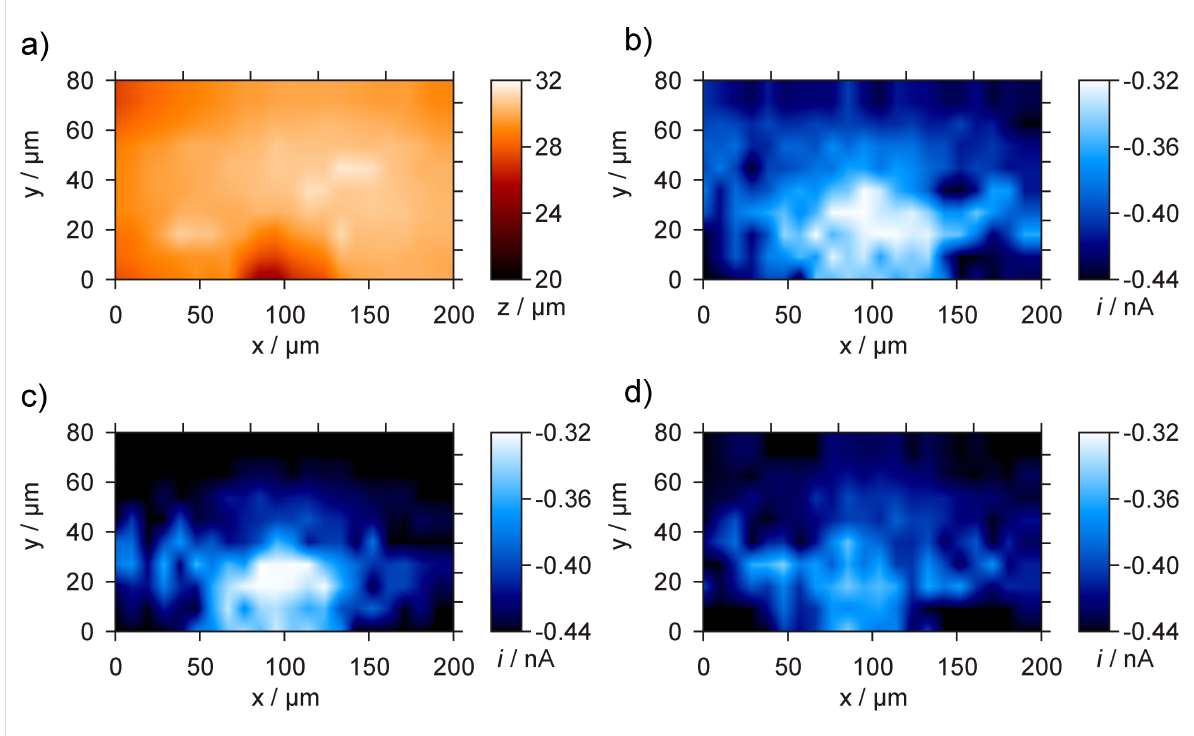
Figure 6: 4D SF/CD-RC-SECM experiment at a microcavity filled with a Pt/C model catalyst. Topography image a) and current images at b) the point of shearforce-contact d , c) d + 4 µm, and d) d + 20 µm. E sample = − 300 mV, E tip,base = 500 mV, E tip,pulse1 = 500 mV, t pulse1 = 0.5 s, E tip,pulse2 = − 600 mV, t pulse2 = 0.5 s, images displayed at t = 0.25 s, d tip = 1.9 µm, f osc = 366.7 kHz, stop criterion: